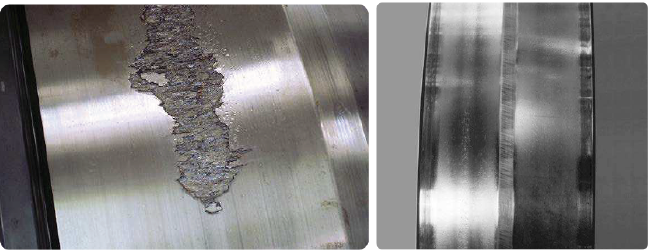
Figure 3. Fatigue failure. Subsurface-initiated ( left ) and surface-initiated ( right ) [27]. Courtesy of SKF.